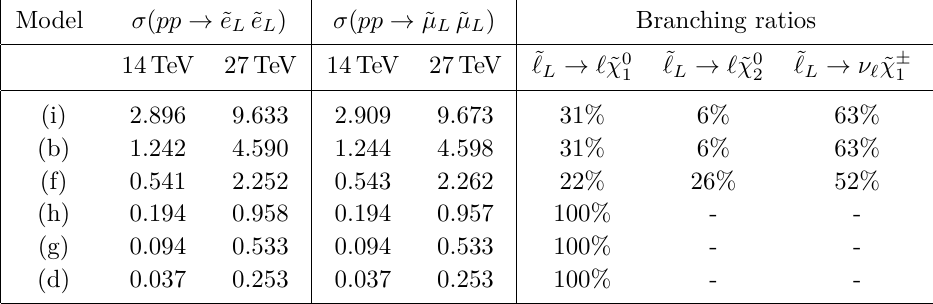
Table 8 . The aNNLO+NNLL pair production cross-sections, in fb, of sleptons at √ and at s = 27 TeV for benchmarks (b), (d) and (f)–(i) of table 1 arranged in decreasing order of production cross sections. Also shown are the slepton branching ratios to electroweakinos and